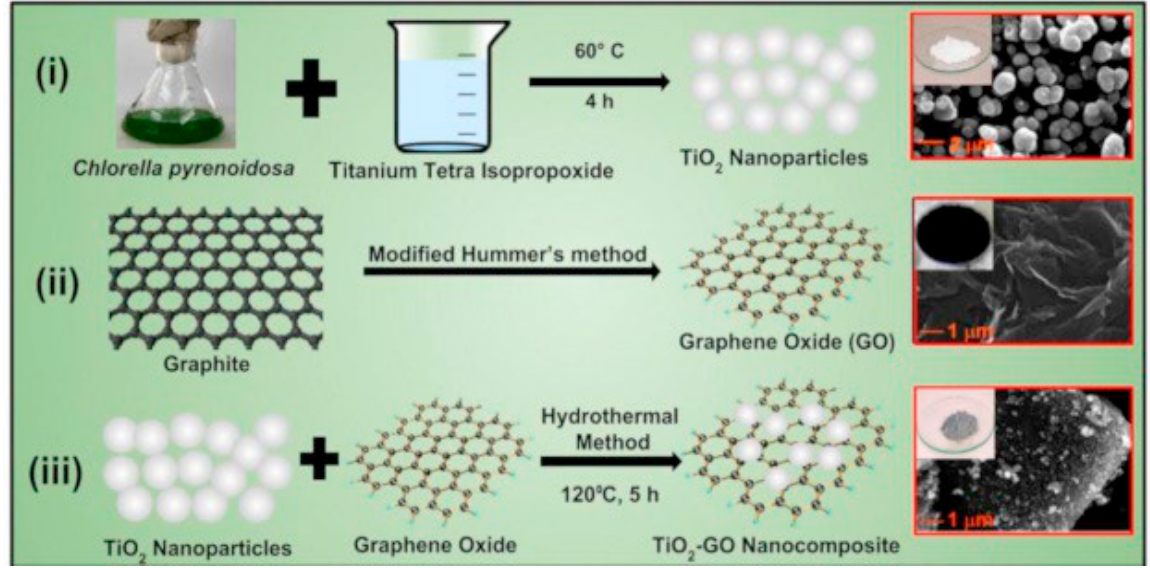
Figure 23. Synthesis process for ( i ) TiO 2 NPs using green alga Chlorella pyrenoidosa , ( ii ) GO, and ( iii ) TiO 2 -GO nanocomposite using a hydrothermal method. Reprinted from [86]. Table 3. A summary of synthesized TiO 2 nanostructures using the hydrothermal method.